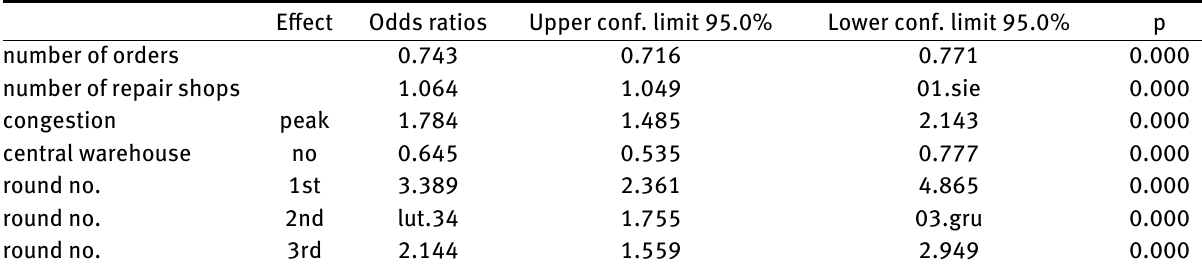
Table 4: Odds ratios for individual predictors Effect Odds ratios Upper conf. limit 95.0% Lower conf. limit 95.0%